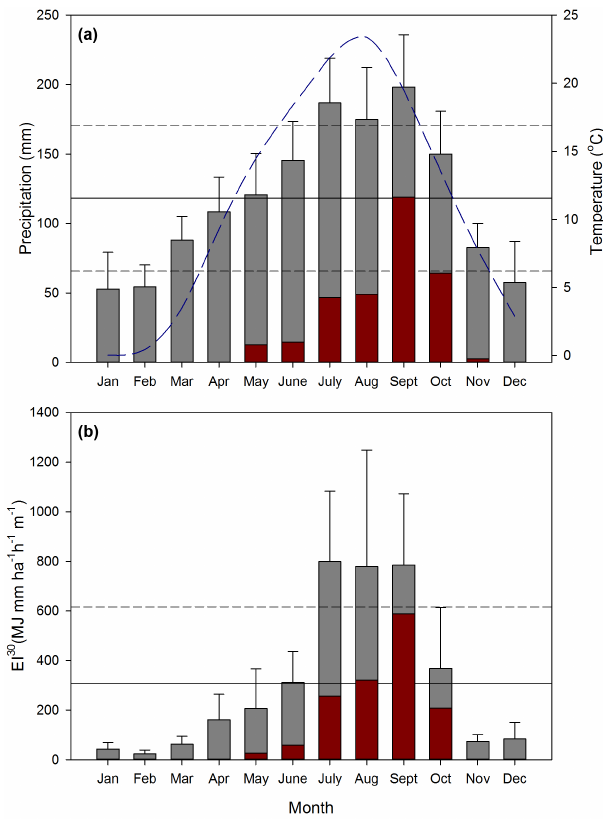
Figure 5. Total (grey) and typhoon-related (red) mean monthly rain- fall (a) and R factor (b) with error bars indicating 1 standard devi- ation from the mean, the solid line representing the monthly mean and dashed lines representing 1 standard deviation from the mean. The mean monthly temperature is plotted (red line) along with mean monthly rainfall (a)